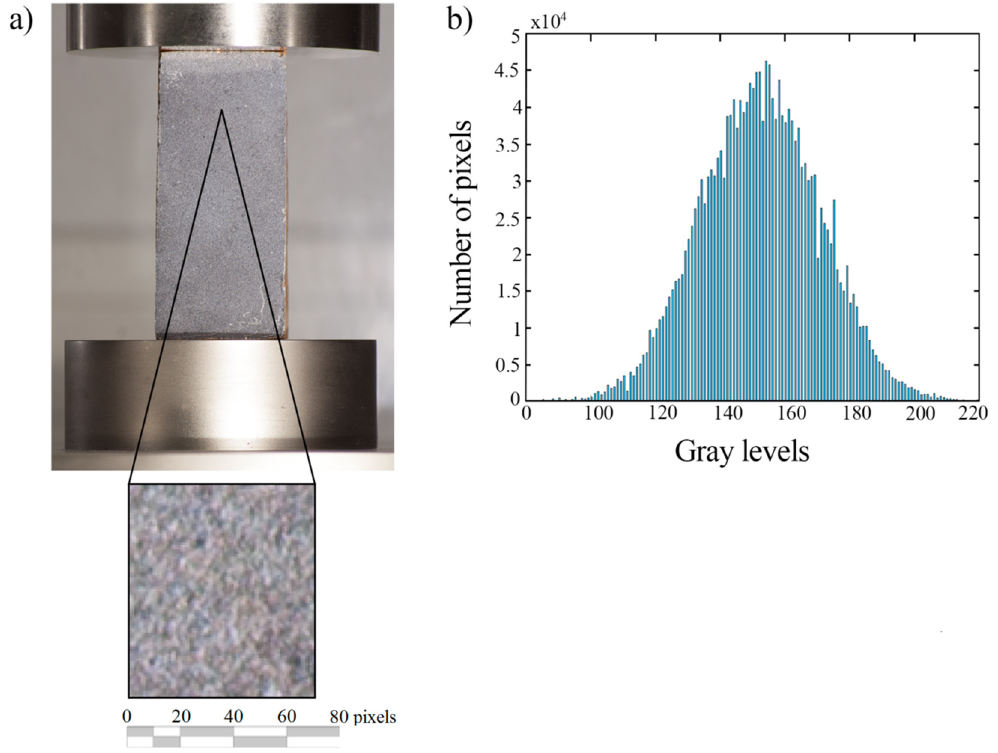
Figure 1. ( a ) Detail view of the brick and speckle pattern applied during the Digital Image Correlation (DIC) test; ( b ) Histogram of the speckle pattern.